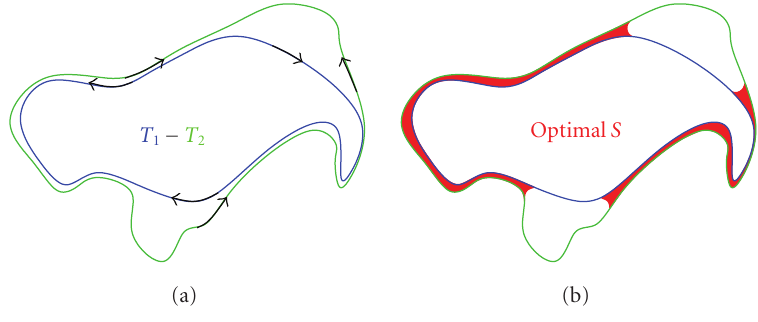
Figure 3.7. The flat norm via the L 1 TV functional provides us with both a distance and an informative optimal decomposition into S and T 1 − T 2 − ∂S . To use L 1 TV on sets, we need that T 1 = ∂ Ω 1 and Ω Ω T = ∂ Ω ⊂ Ω ⊂ Ω 2 2 and either 1 2 or 2 1 . Using a direct method for computing the need these inclusions. Alternatively, we can identify the di ff erence between two shapes ∂ Ω 1 and ∂ Ω 2 as the boundary of the set Ω 1 (cid:2) Ω 2 . Then we can use L 1 TV for all codimension 1, boundary shape di ff erences, without requiring